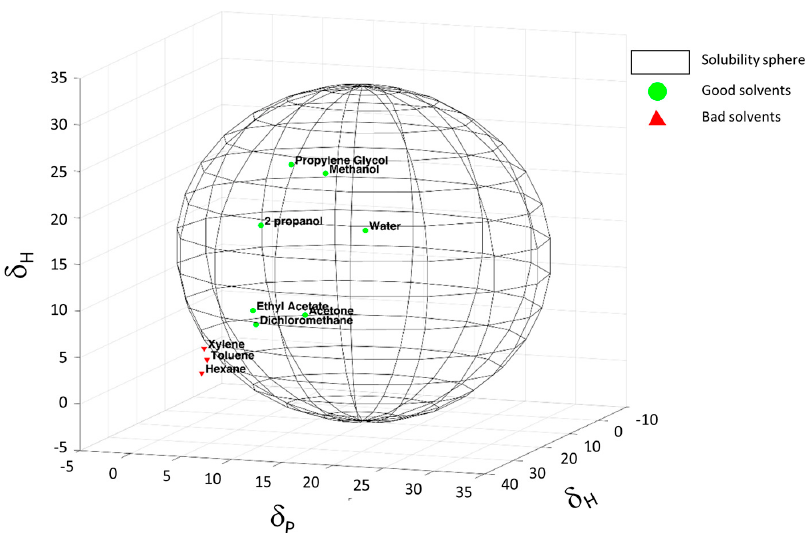
Figure 5. Hansen solubility sphere calculated for MWCNT/PPGP c adduct. The green circles correspond to the suitable solvents (within the radius of interaction), the red triangles to the wrong solvents (outside the sphere).